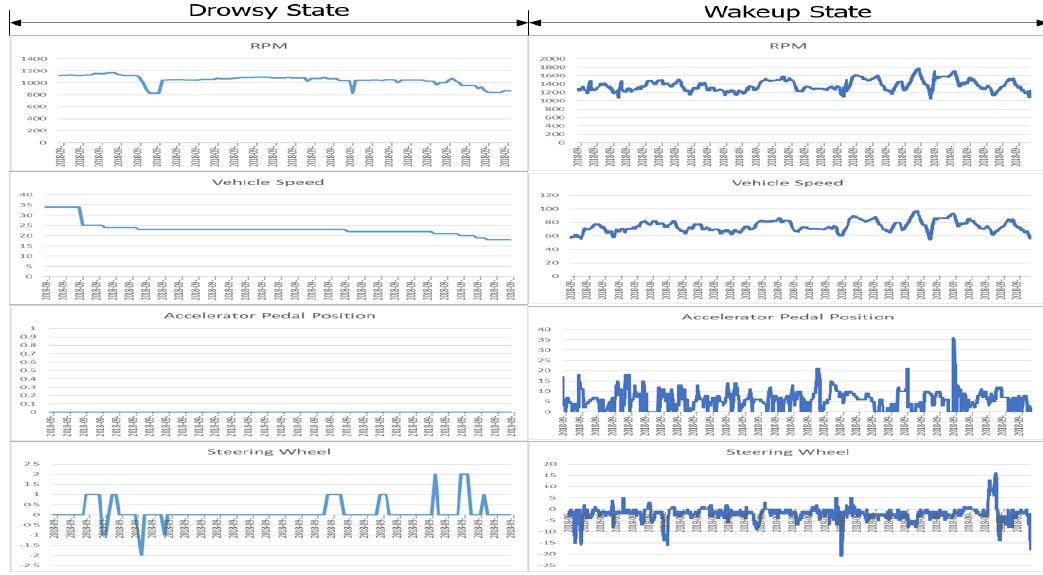
Figure 7. OBD-II data analysis: drowsy state vs. non-drowsy state at a steady